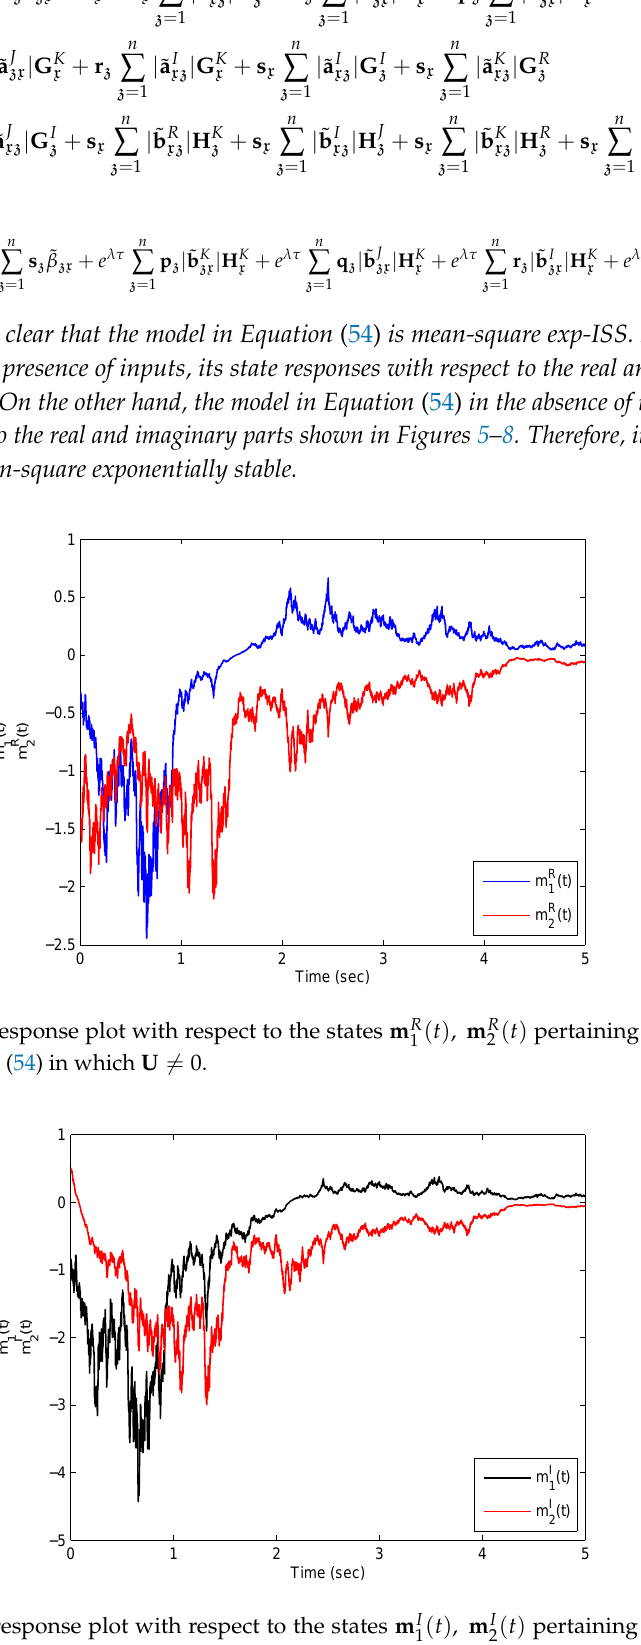
Figure 2. A time response plot with respect to the states m I model in Equation (54) in which U (cid:54) =